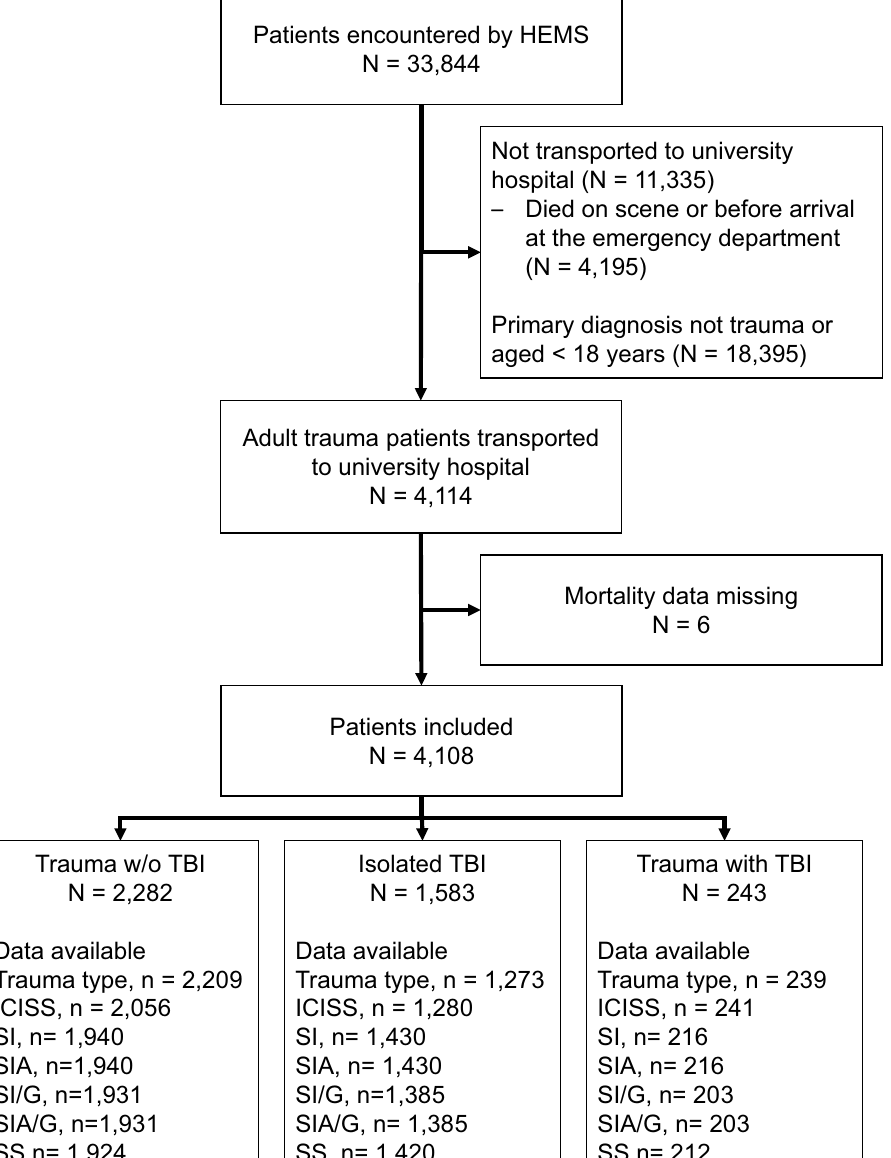
Figure 1. Patient selection flowchart. HEMS, Helicopter Emergency Medical Services; TBI, traumatic brain injury; ICISS, ICD-10 based Injury Severity Score; SI, shock index; SIA, SI multiplied by age; SI/G, SI divided by Glasgow Coma Score; SIA/G, SI multiplied by age and divided by Glasgow Coma Score; SS, SI divided by oxygen